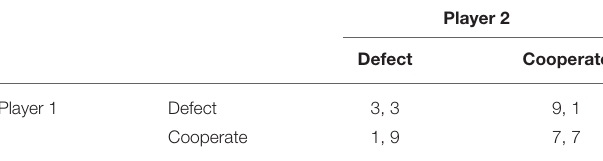
TABLE 1 | The prisoner’s